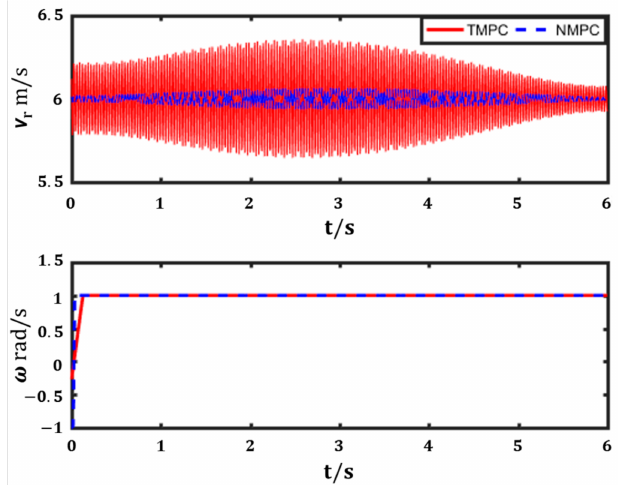
Figure 8. The control input of the TMPC and NMPC controllers under the